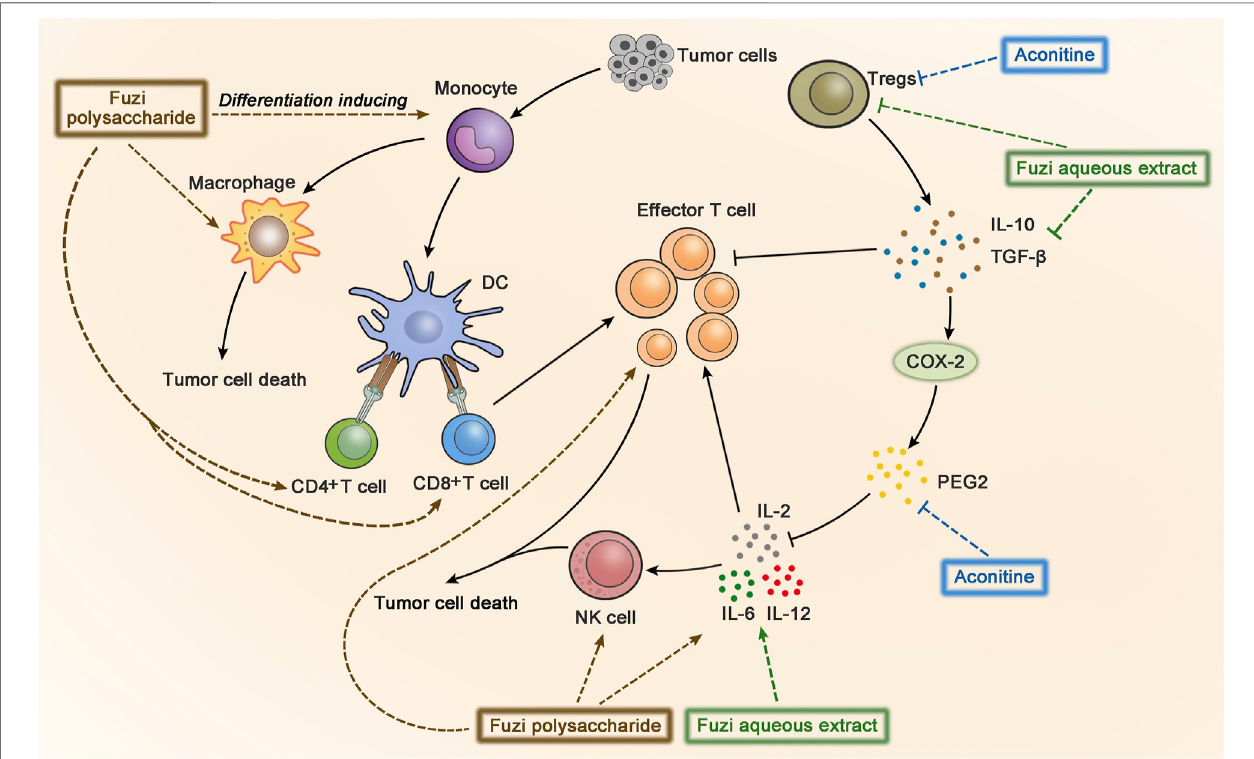
FIGURE6| TheanticancerimmunomodulatorymechanismofFuzi.FuziinducedperipheralbloodmonocytestodifferentiateintoDC,activatedTlymphocytes,and increased the expression of macrophages, CD4 + , CD8 + T cells, NK cells, IL2, IL-12, IL-6, etc. Besides, Fuzi reduced the production of IL-10, TGF- β , Treg, and arrested PGE2/COX-2 pathway. The blue, brown and green dotted arrows indicated the in fl uence induced by alkaloids, FPS and Fuzi aqueous extract respectively.